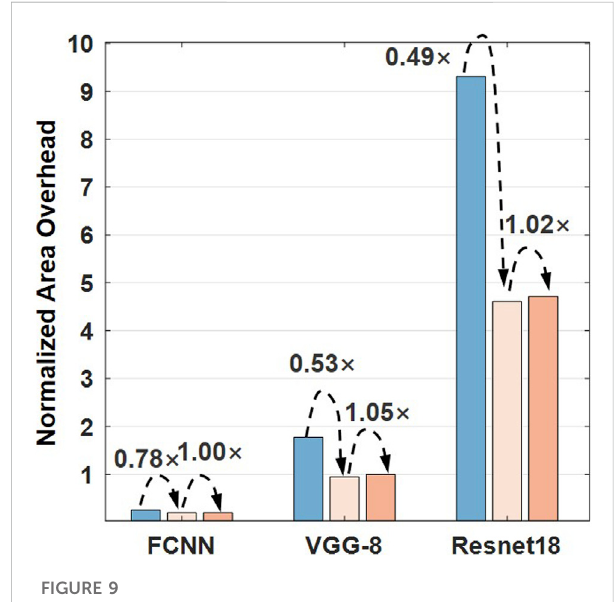
FIGURE 9 Area overhead of different DNN models.